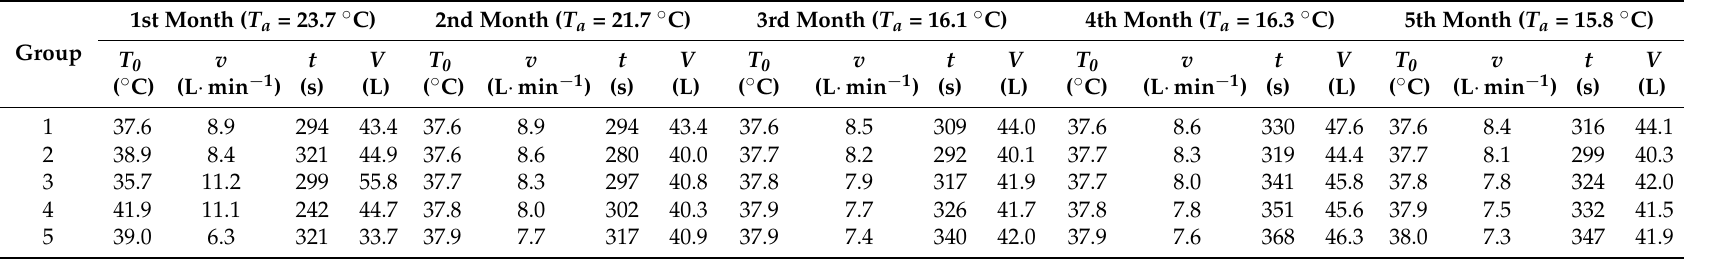
Table 3. Operating parameters of a Water Efficiency Labelling Scheme (WELS) rated showerhead ( k = 2.46).